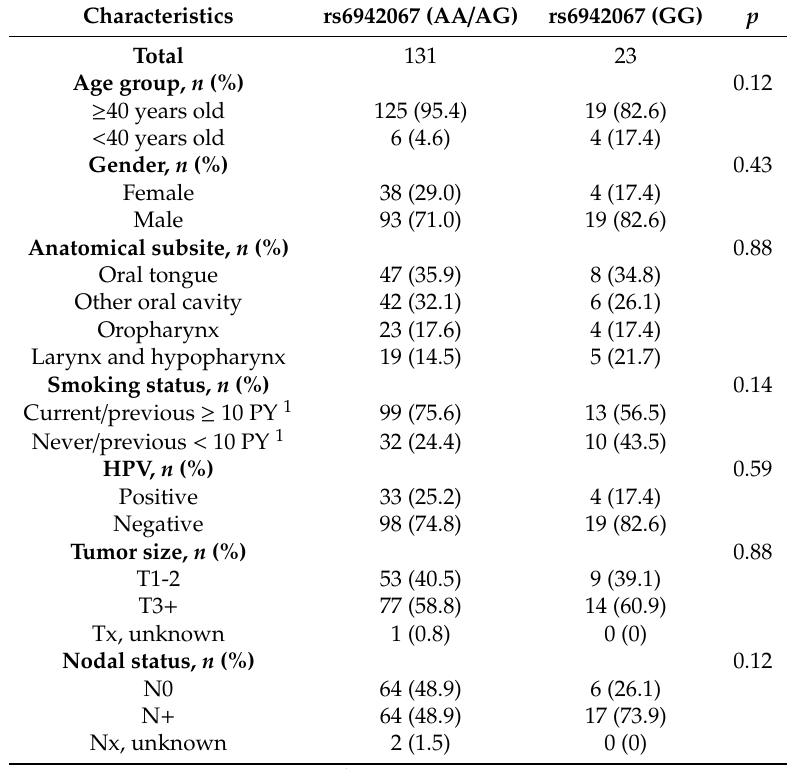
Table 1. Clinical features of the TCGA HNSCC cohort stratified by rs6942067